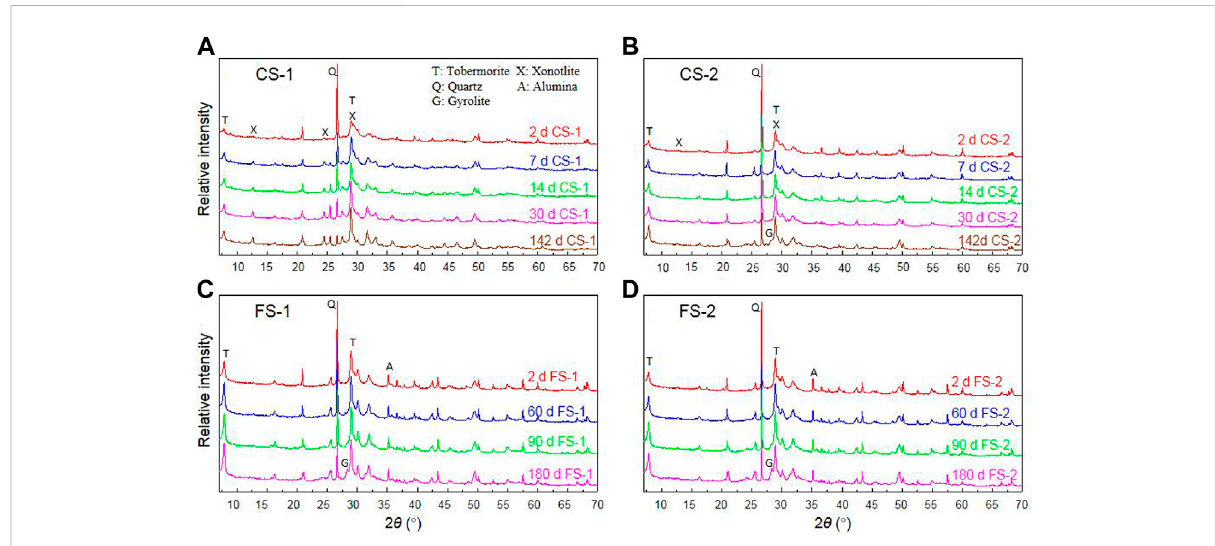
FIGURE 2 X-ray diffraction curves of sample cured under high-pressure and high-temperature conditions: (A) slurry CS-1, (B) slurry CS-2, (C) slurry FS-1, and (D) slurry FS-2.